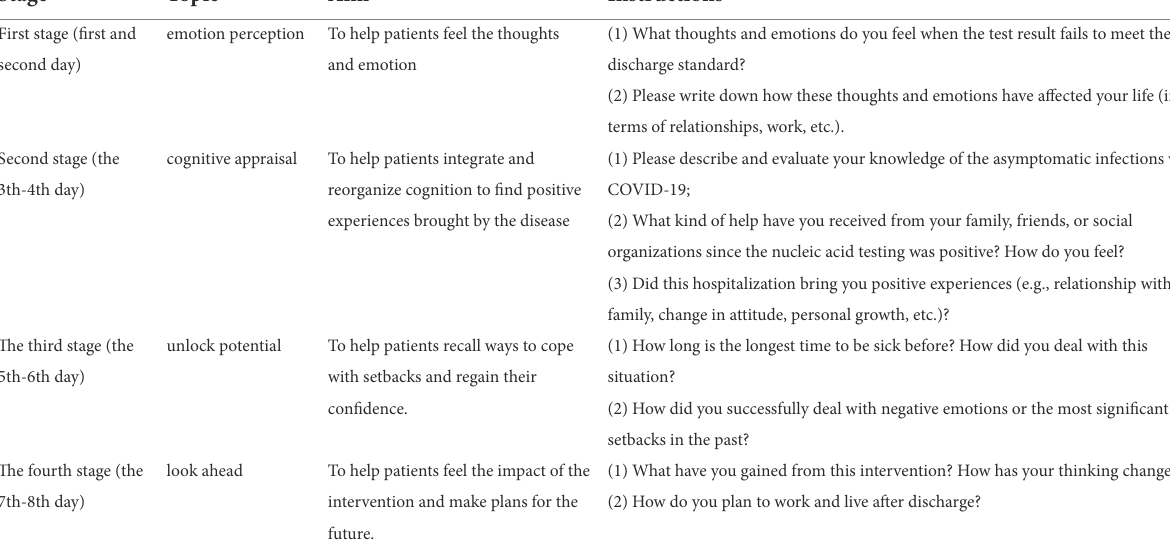
TABLE 1 EW intervention